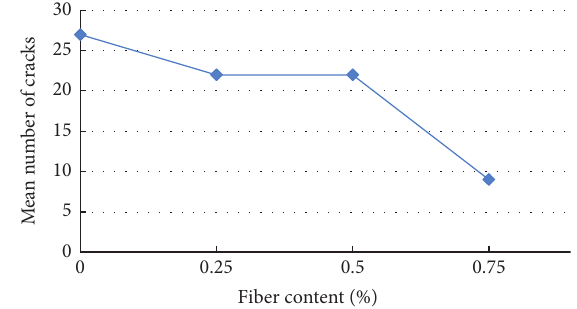
Figure 5: Mean bending strength of mortar.